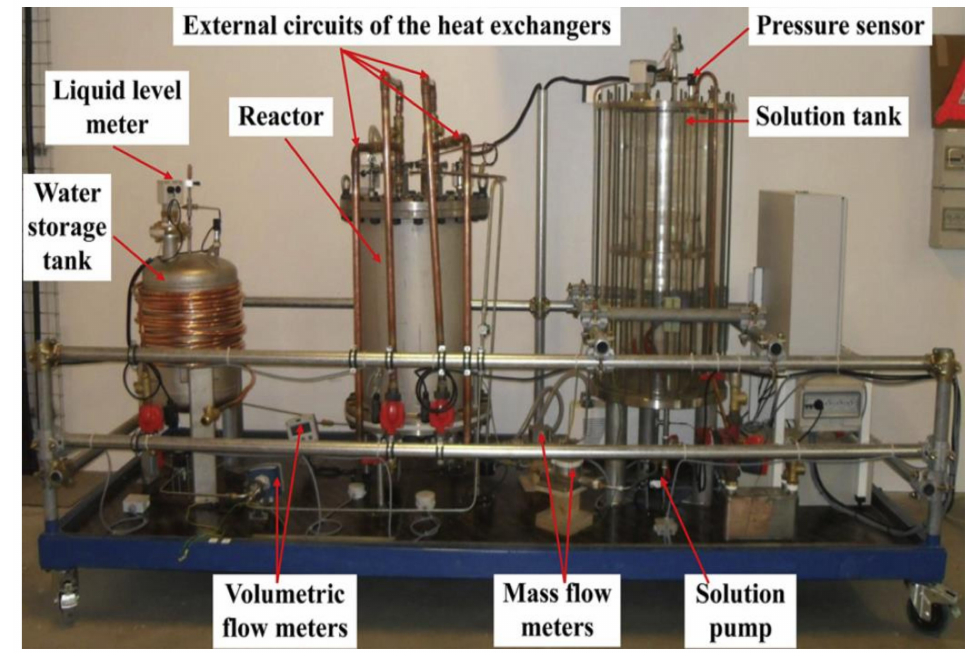
Figure 22. Long-term absorption thermal energy storage [44].